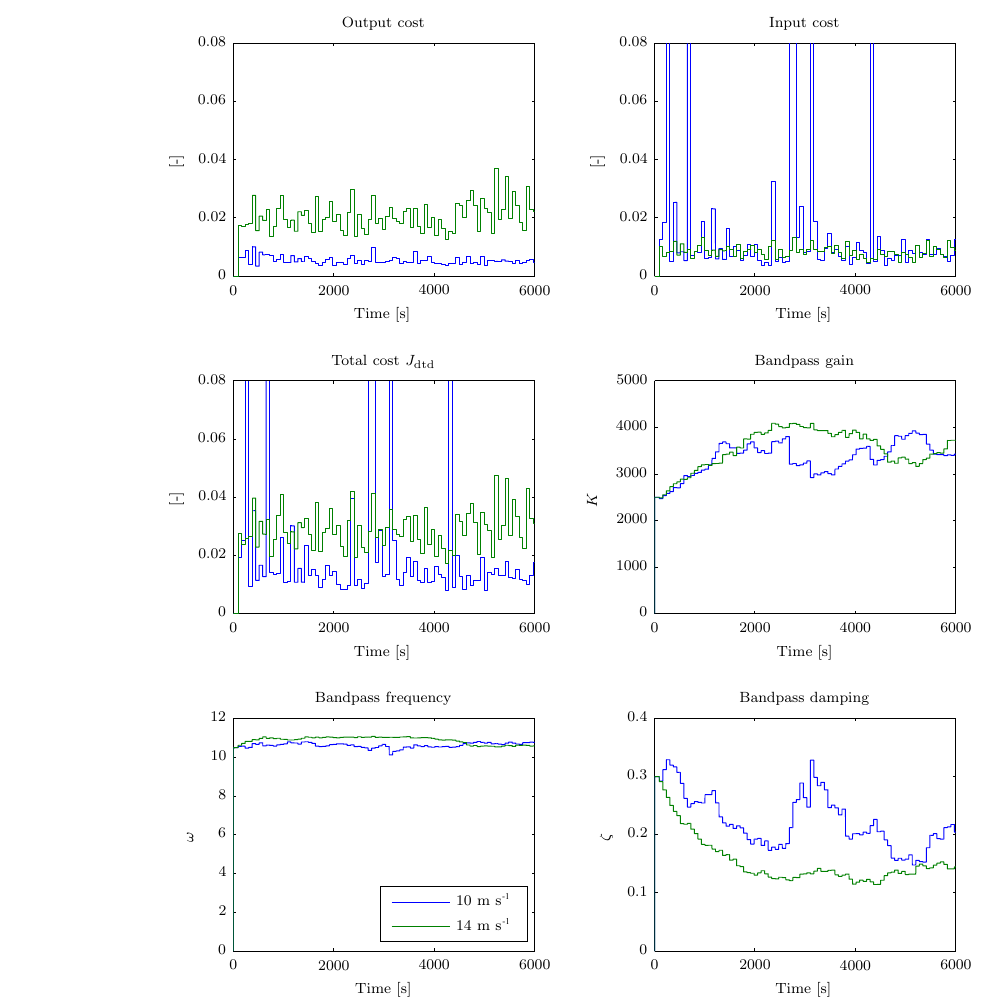
Figure 13. Comparison of IFT performance for turbulent wind with mean wind speeds 10 and 14ms − 1 , both with 10% turbulence intensity. Results shown are obtained with γ = 0 . 3 and λ = 5 × 10 − 7